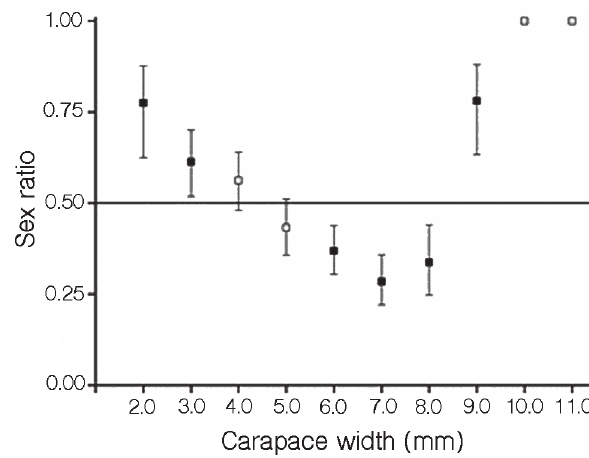
Figure 4. Sex ratio (estimate ± SD) by size class of Panopeus austrobesus in the mussel farm at Itaguá Beach, Ubatuba, State of São Paulo, Brazil. Black squares indicate a deviation from a 1:1 sex